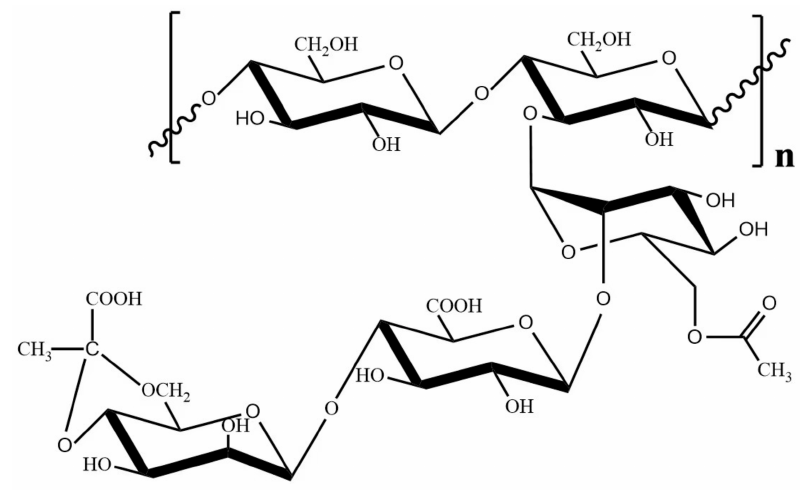
Figure 1. The structure of xanthan